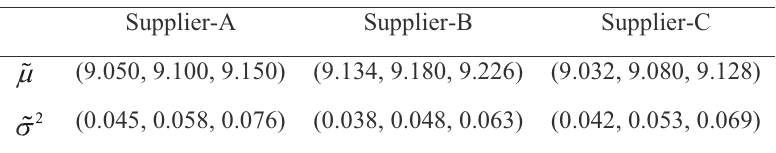
Table 3 The fuzzy values for supplier alternatives